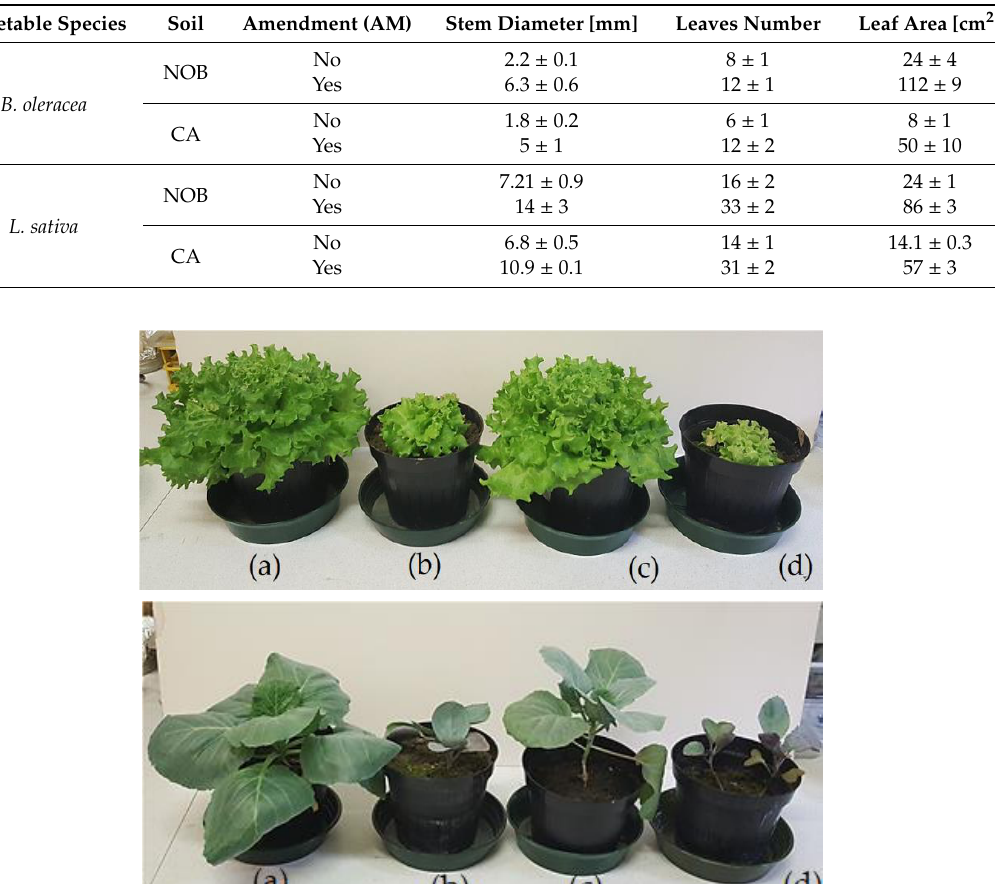
Table 5. Morphometric parameters relating to Lactuca sativa and Brassica oleracea plants grown for 3 months under the investigated experimental conditions.